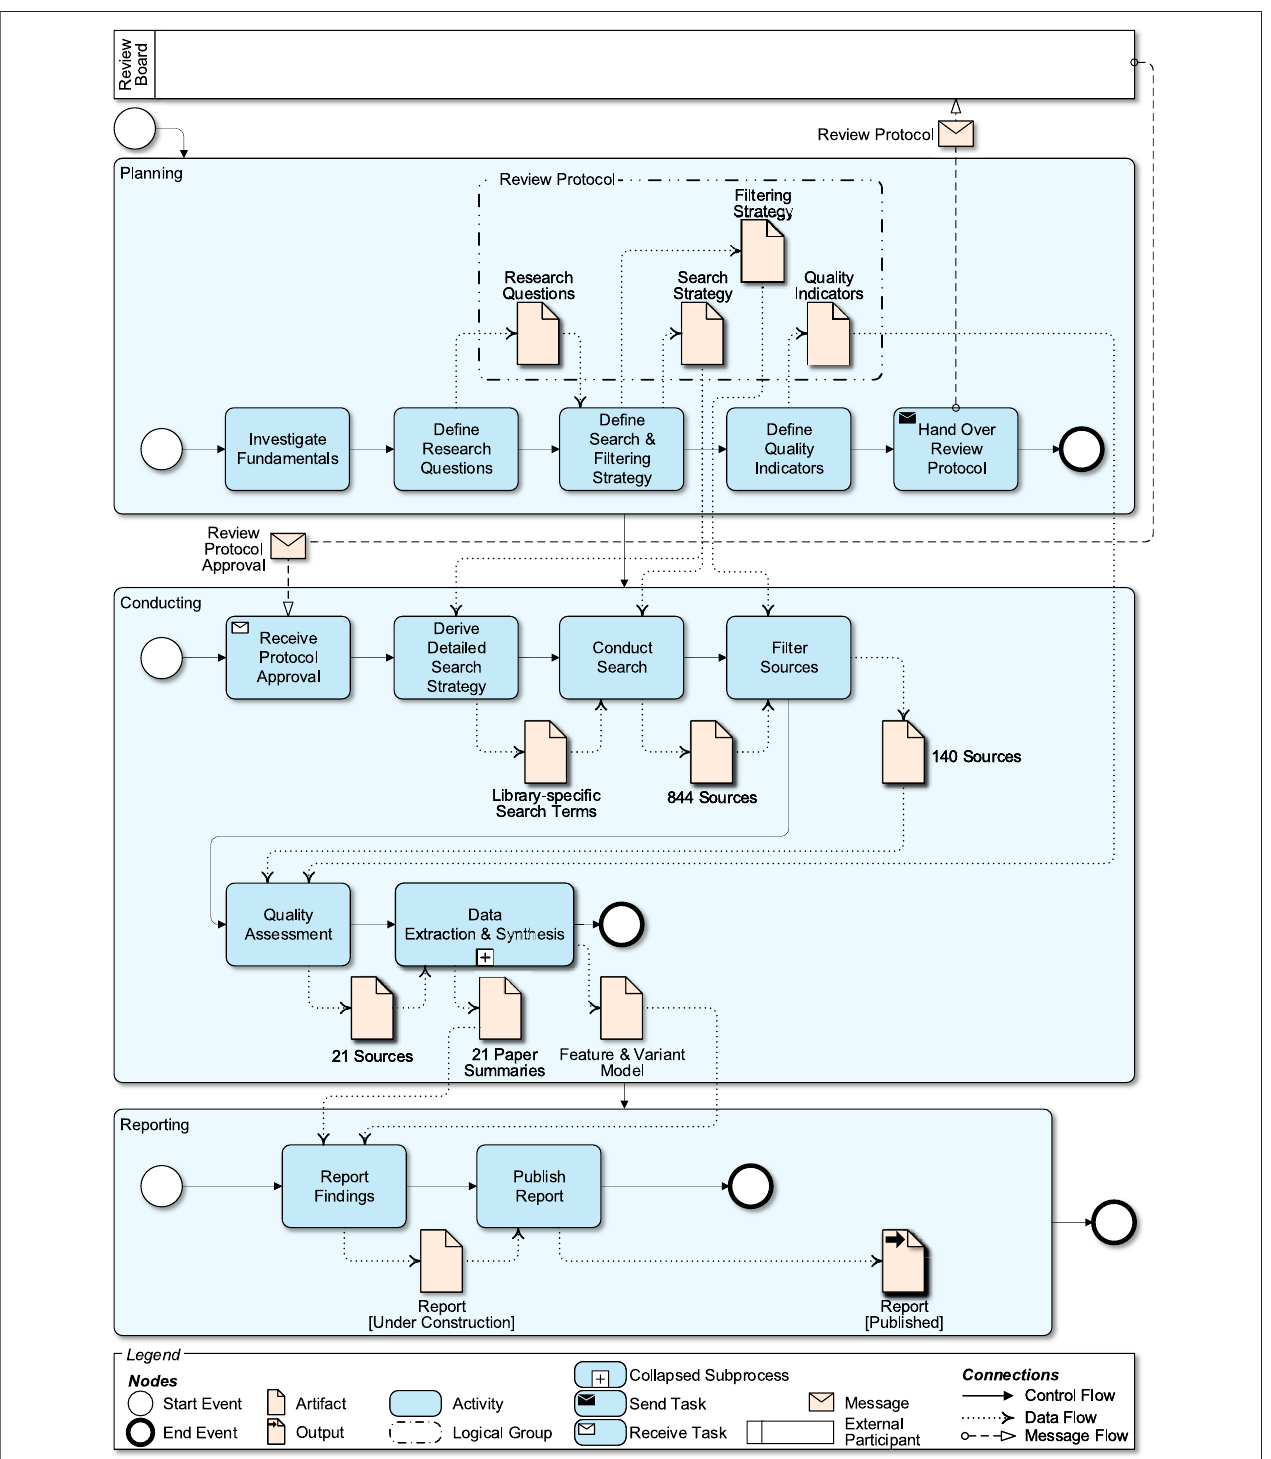
FIGURE 1 | The SLR process including the number of publications per search step.